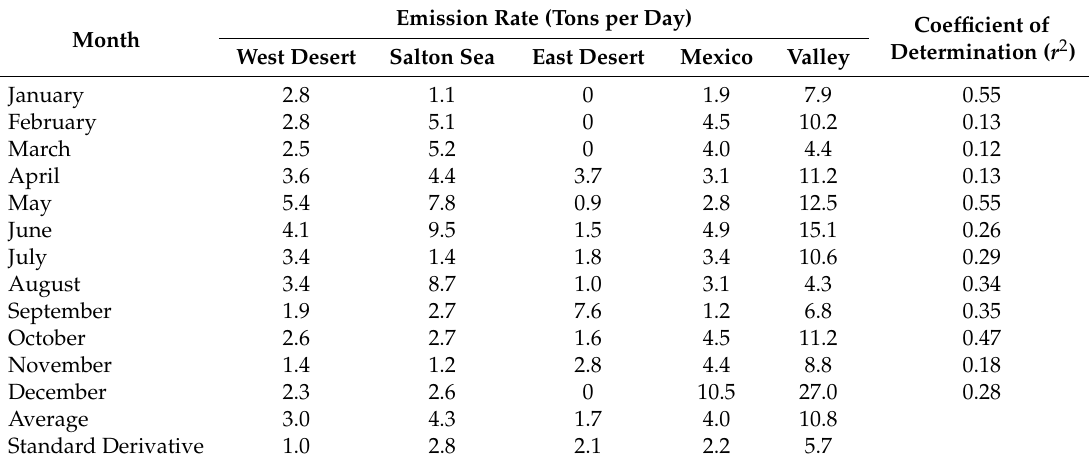
Table 3. Emission rates and coefficient of determination of modeled versus measured monthly-averaged concentrations at 21 IVAN measurement stations for different months during